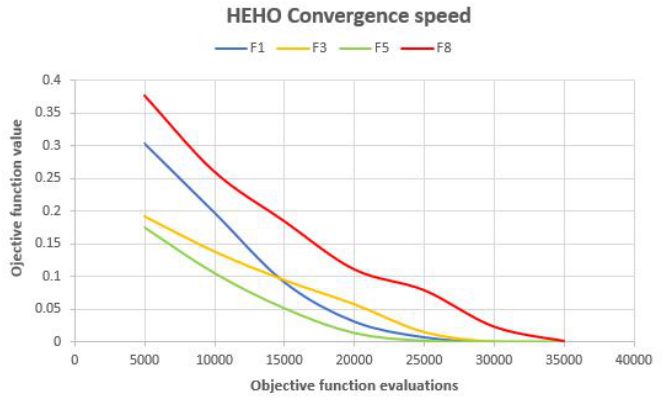
Figure 3. Hybridized elephant herding optimization (HEHO) convergence speed for some unconstrained